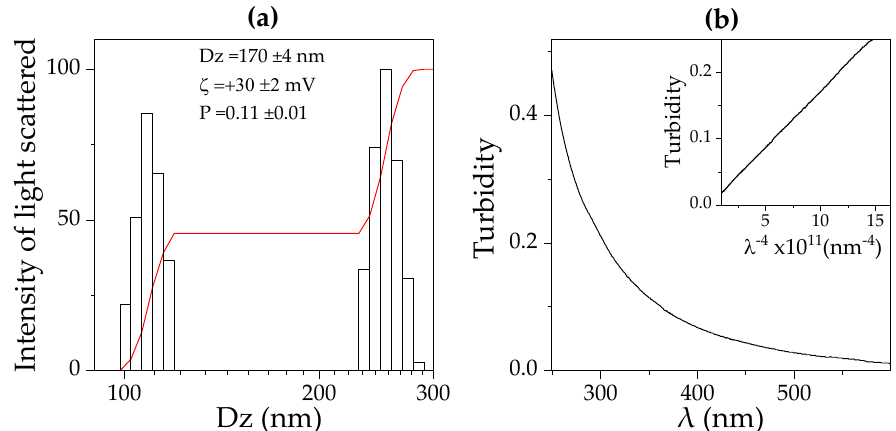
Figure 1. Scanning electron microscopy (SEM) of poly (diallyldimethylammonium chloride) (PDDA) / ovalbumin (OVA) nanoparticles (NPs) at [PDDA] = 0.01 mg · mL − 1 and [OVA] = 0.1 mg · mL − 1 under low ( a ) and high magnification ( b ). The mean diameter (D) of dried NPs from ImageJ software was D = 234 ± 42 nm.